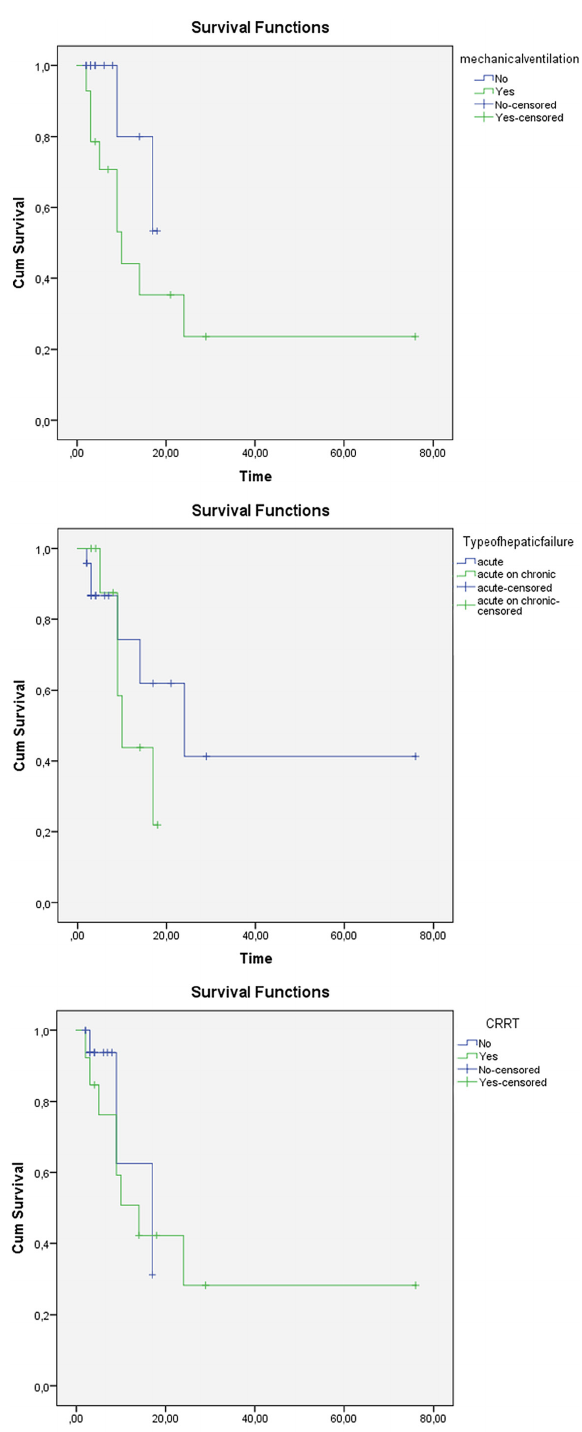
Figure 2. Kaplan–Meier survival curves for mechanical ventilation support, hepatic failure type, and CRRT therapy. CRRT, continue renal replacement